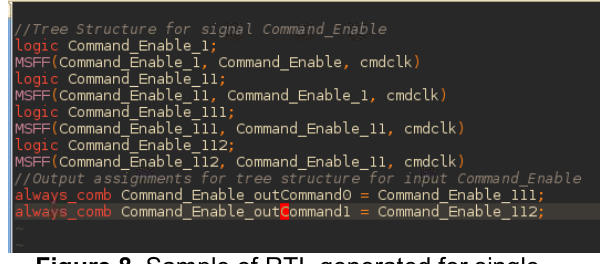
Figure 8. Sample of RTL generated for single signal